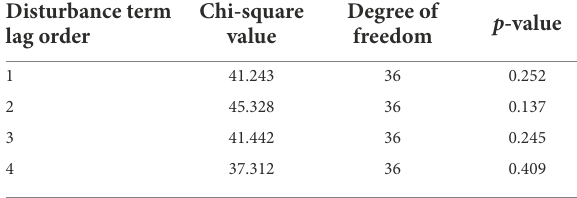
TABLE 4 LM test of autocorrelation of VAR disturbance.